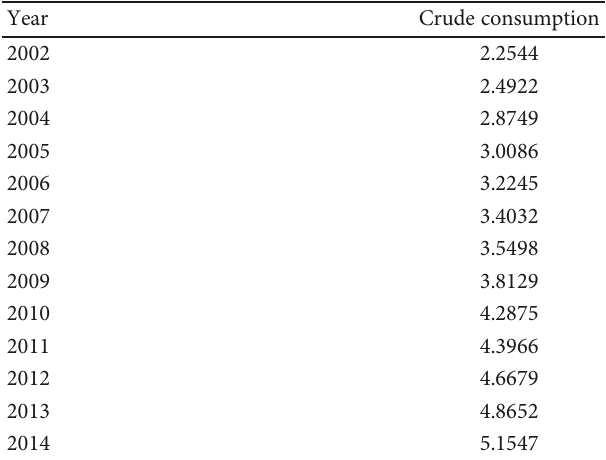
Table 1: China ’ s crude consumption (units: 100 million tons) during 2002 – 2014. Year Crude